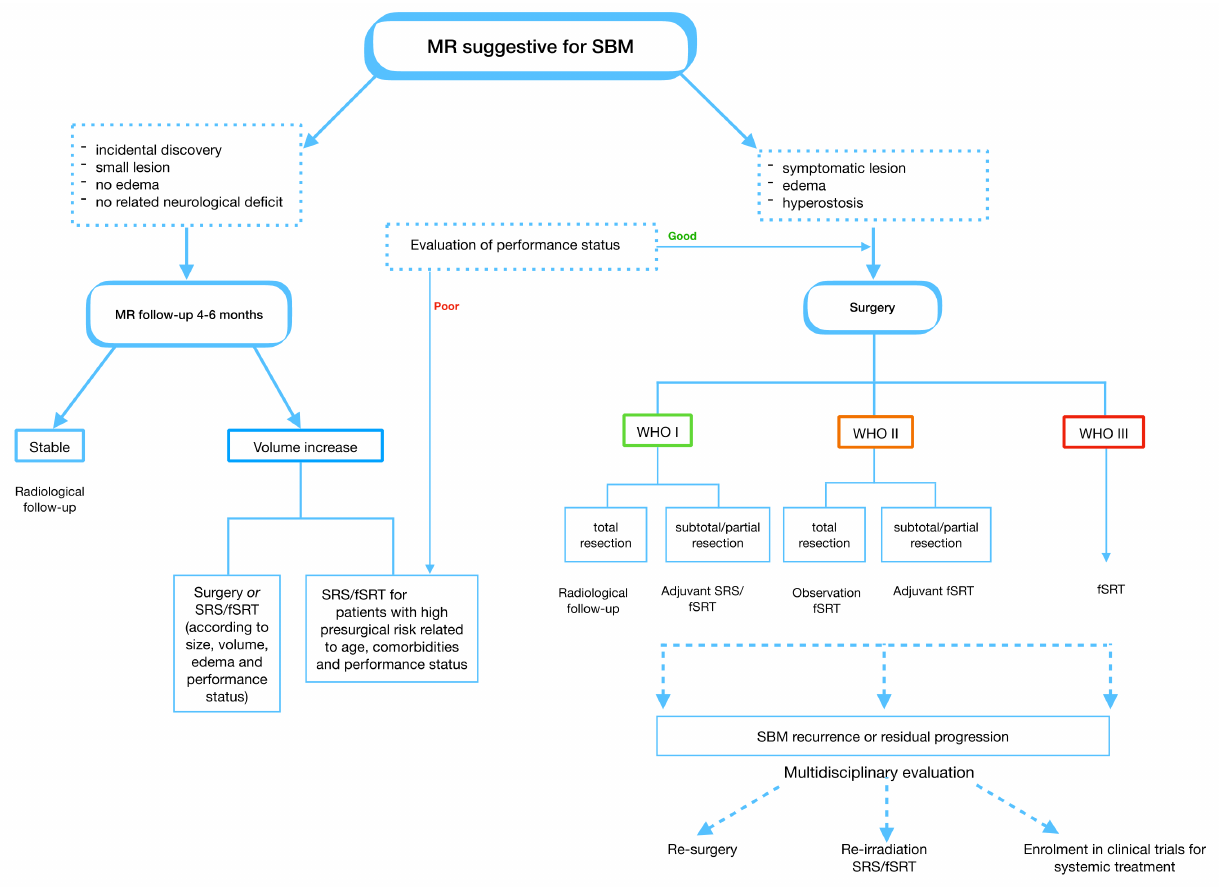
Figure 3. Workflow for the standard treatment options in SBMs. When a “wait and see” approach is chosen, MRI is performed every 6 months. If patients remain asymptomatic, MRI is performed annually after 5 years. For WHO grade III SBMs, fSRT is recommended across all surgical resection classes. WHO, World Health Organization; fSRT, fractionated stereotactic radiotherapy; SRS, stereotactic